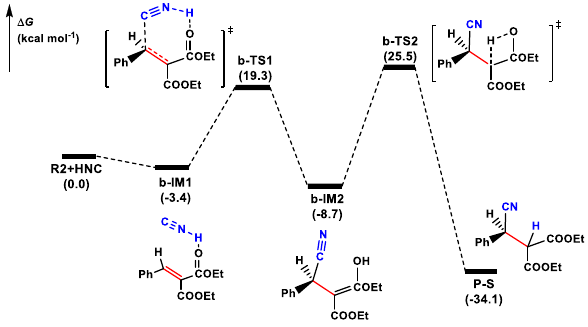
Figure 3. Potential energy profile for the noncatalytic cyanation reaction of olefin.